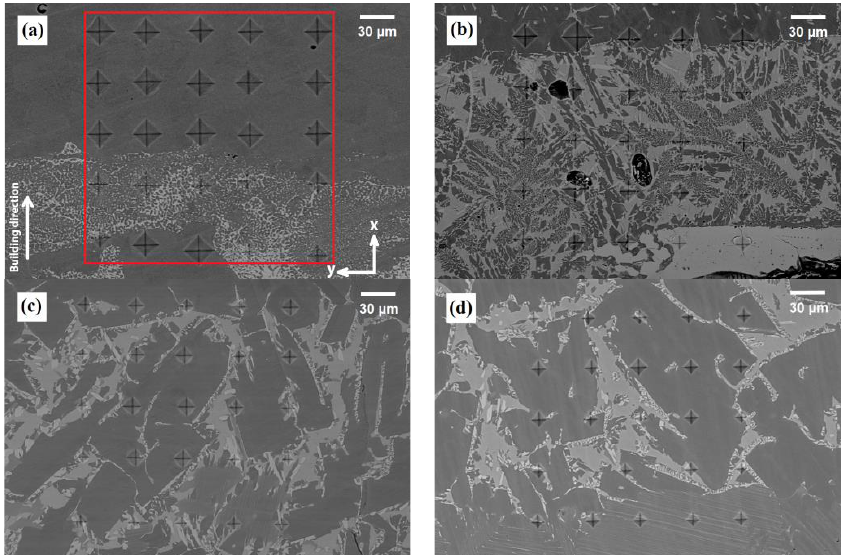
Figure 7. Microhardness indentations on ( a ) as-built, ( b ) HIPed samples, and the samples solution annealed at ( c ) 1320 and ( d ) 1360 °C. Table 3. Average hardness values (HV 0.1) measured for each sample.